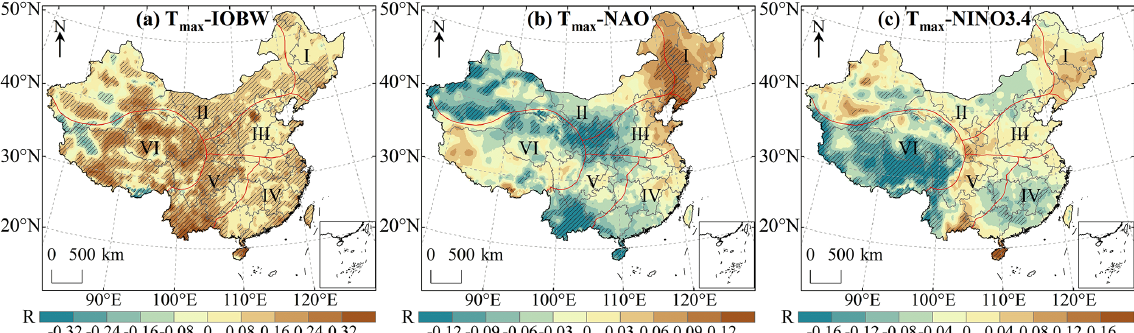
Figure 18. Correlation analysis between T max and IOBW (a) , and NAO (b) and NINO3.4 (c) in China during 1979–2018. The shaded areas indicate correlations that are significant at the 0.05 level.